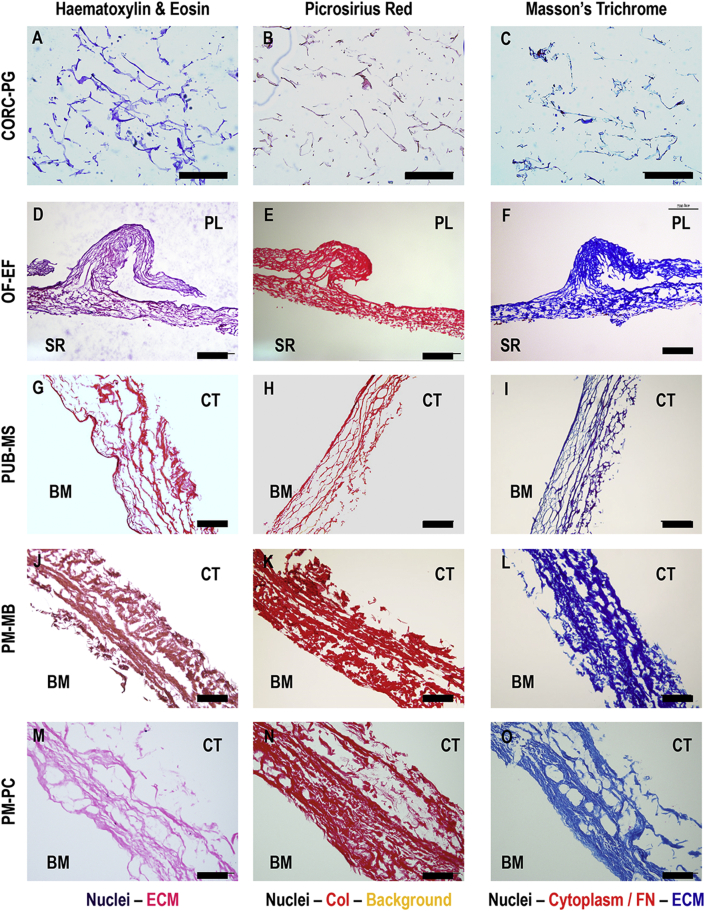
Histology analysis with hematoxylin/eosin, picrosirius red and Masson's trichrome of CORC-PG, OF-EF, PUB-MS, PM-MB, and PM-PC revealed a loose structure for the CORC-PG and a dense structure for the tissue graft materials. Scale bars 200 μm.